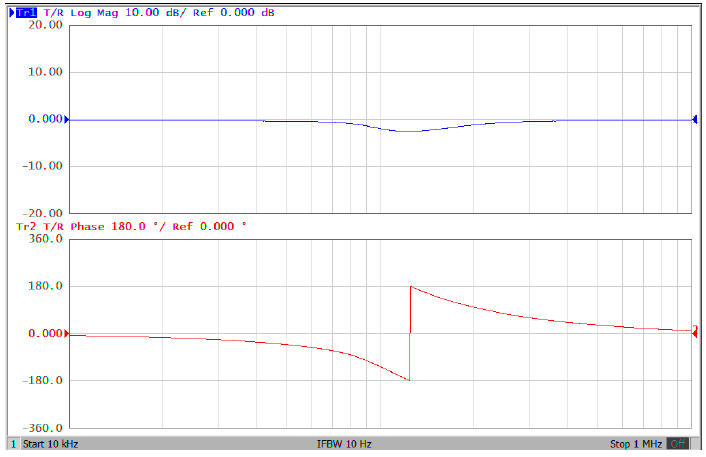
Figure 38. Experimentally observed gain and phase responses of the AP filter realized in case II.